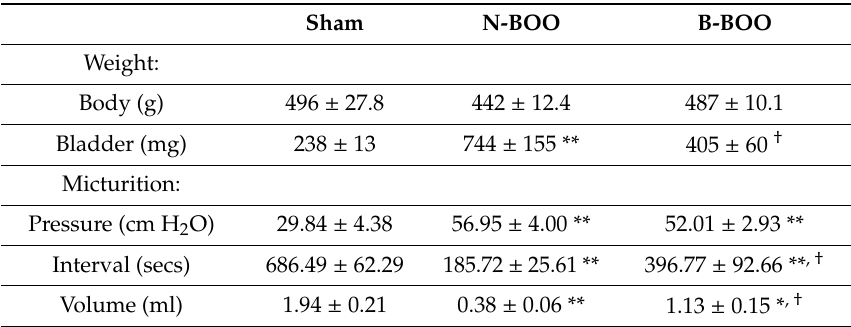
Table 1. Results in 6 sham-operated rats, 6 BOO rats received the normal diet (N-BOO) and 6 BOO rats received the Blueberry diet (B-BOO).